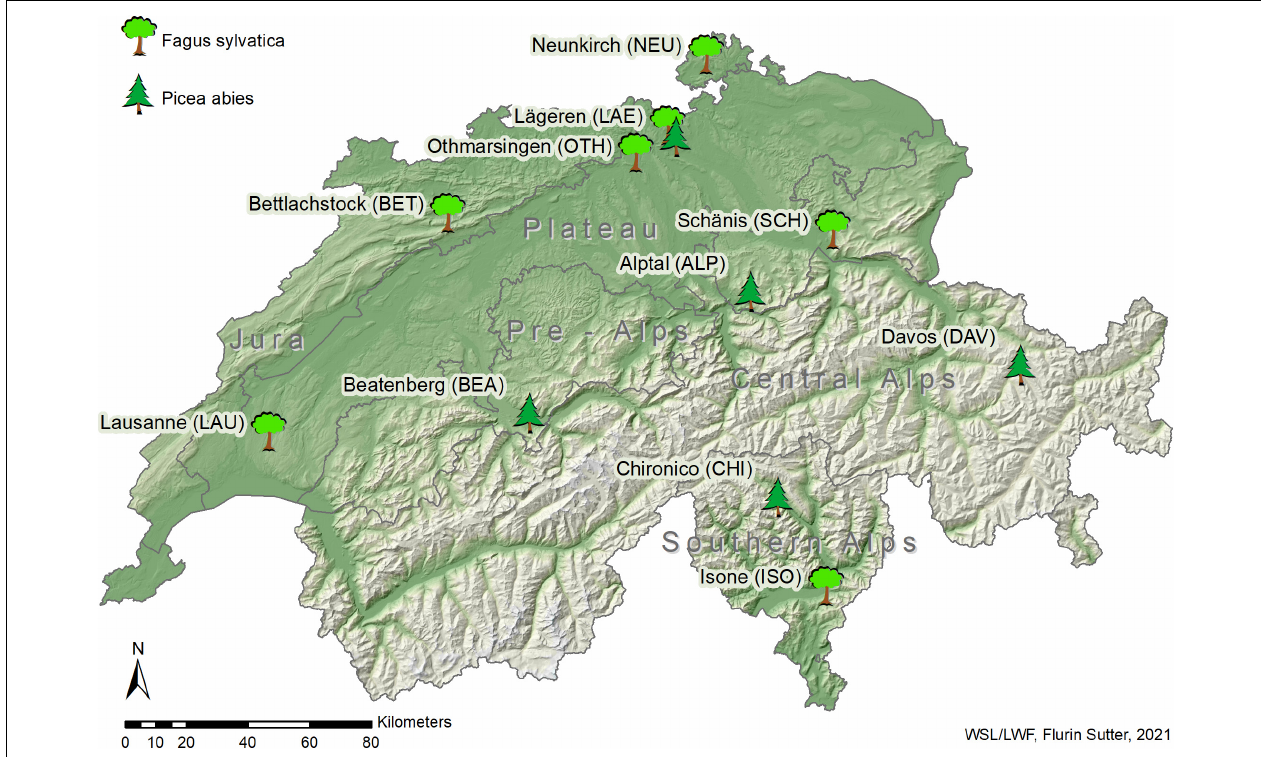
FIGURE 1 | Locations of the 11 study plots distributed across Switzerland with the investigated main tree species European beech ( Fagus sylvatica ) and Norway spruce ( Picea abies